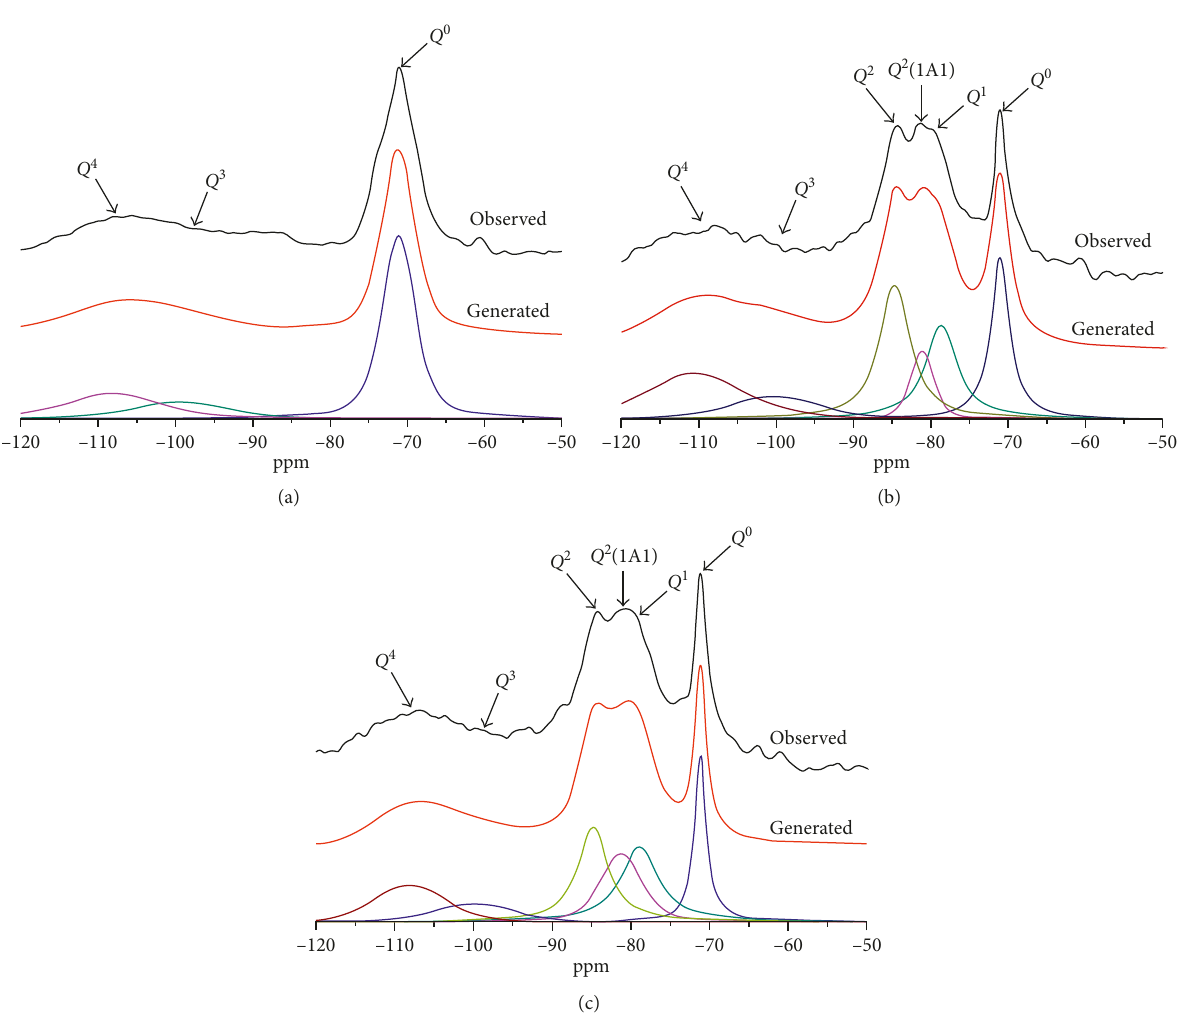
Figure 7: 29 Si-NMR spectrum of cement-FA paste. (a) Unhydrated C-FA; (b) C-FA hydrated for 60d; (c) C-FA with 0.06% TIPA hydrated for